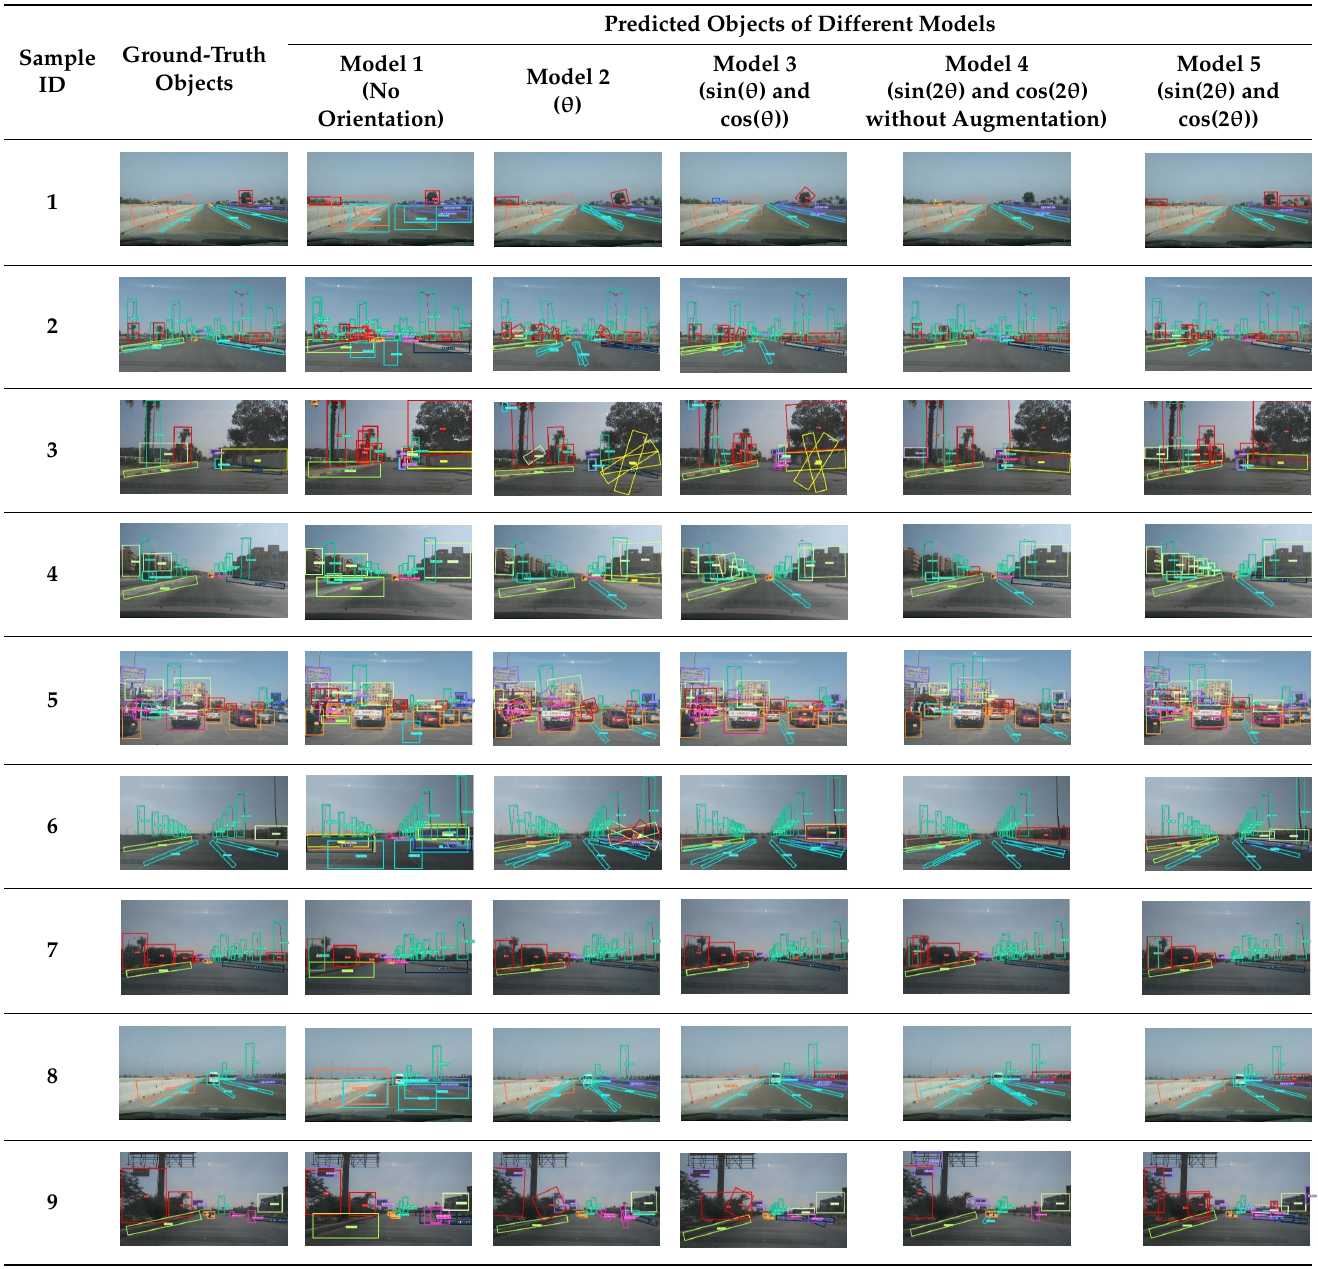
Table 5. Object detection results on random samples from the test data (samples unseen during training time).